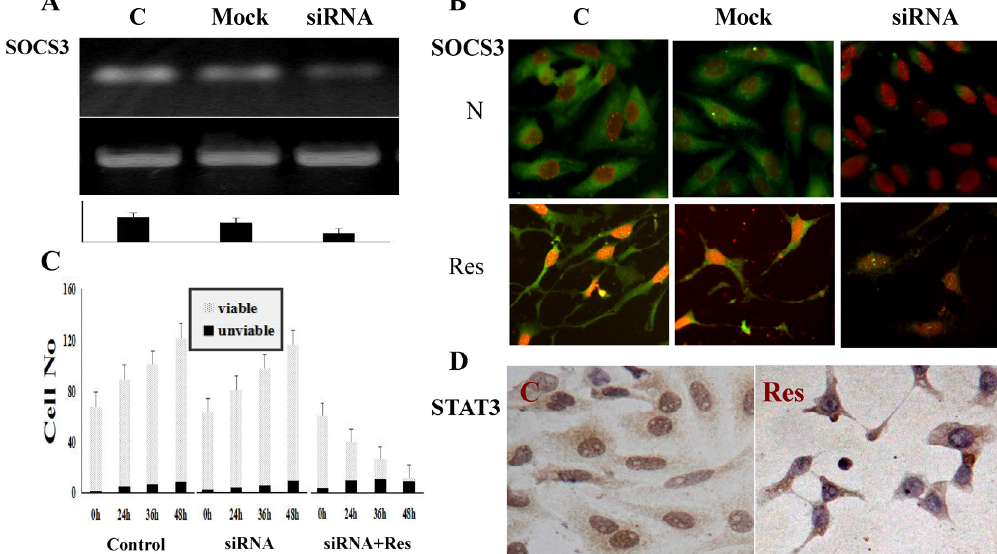
Figure 6. Knockdown of SOCS3 expression and its influence in STAT3 activation, resveratrol-sensitivity and axon-like process regeneration of medulloblastoma UW228-3 cells. ( A ) RT-PCR demonstration of SOCS3 downregulation in SOCS3-specific siRNA transfected UW228-3 cells (siRNA). The normally cultured (C), and mock RNA transfected (mock) cells are used as controls; ( B ) Immunofluorescent illustration (20×) of SOCS3 expression and intracellular distribution in normally cultured (C), mock RNA transfected (mock) and SOCS3-specific siRNA transfected UW228-3 cells (siRNA) before (N) and after resveratrol treatment (Res); ( C ) Viable:nonviable cell counting (mean cell number/visual field) reveals no influence of SOCS3 knockdown in the proliferation and resveratrol sensitivity of UW228-3 cells. N, UW228-3 cells without siRNA transfection; siRNA, normally cultured SOCS3 siRNA transfected UW228-3 cells; siRNA+Res, 100 µ M resveratrol-treated UW228-3 cells with SOCS3 siRNA transfection; ( D ) SOCS3 knockdown exerts little effect on STAT3 activation in normally cultured cells (C) and resveratrol-caused STAT3 inactivation of UW228-3 cells (Res).